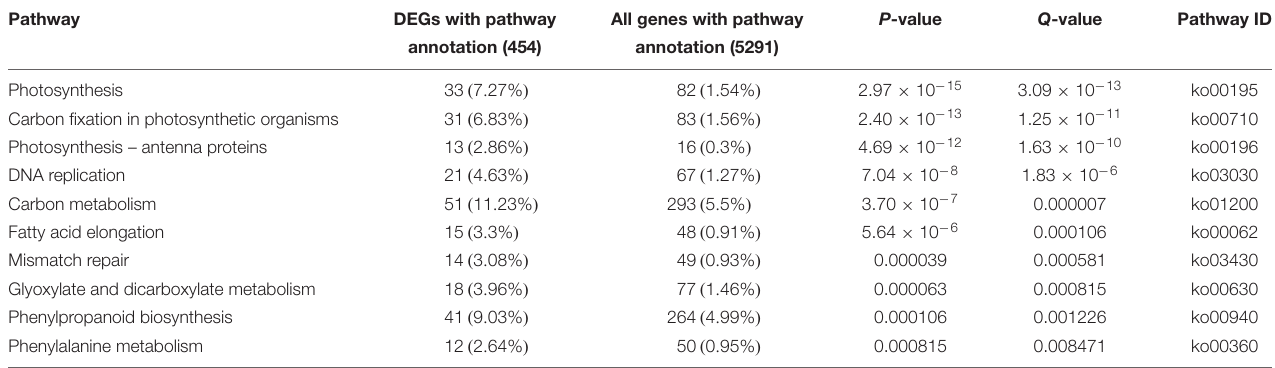
TABLE 1 | DEGs most enriched KEGG